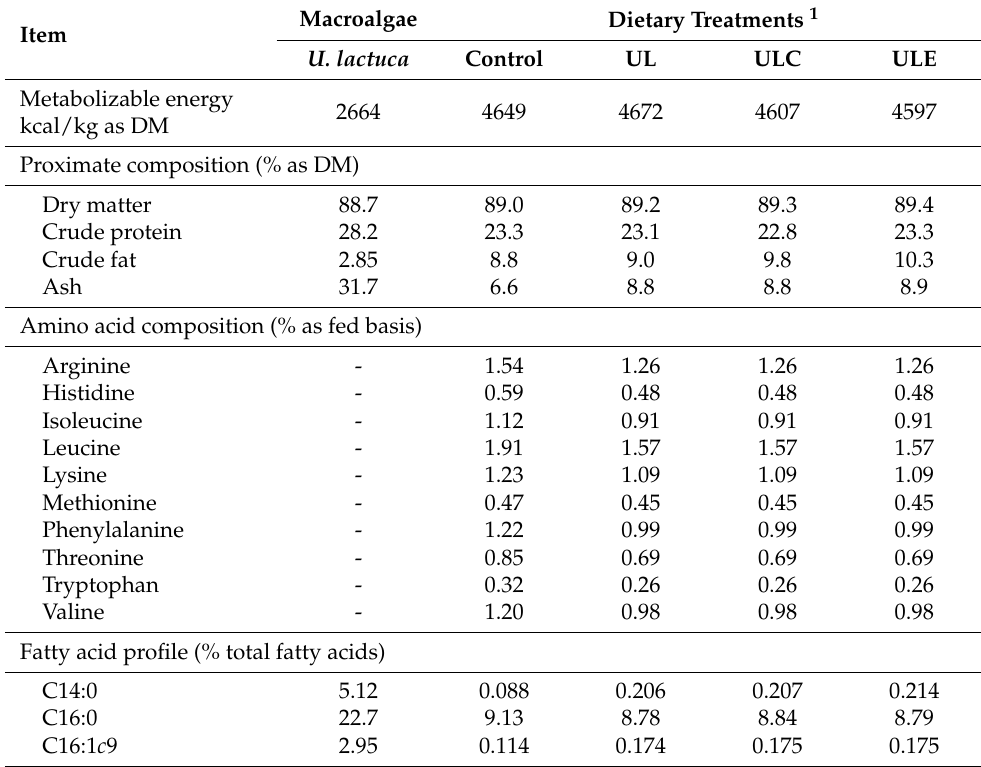
Table 2. Chemical composition of U. lactuca and experimental